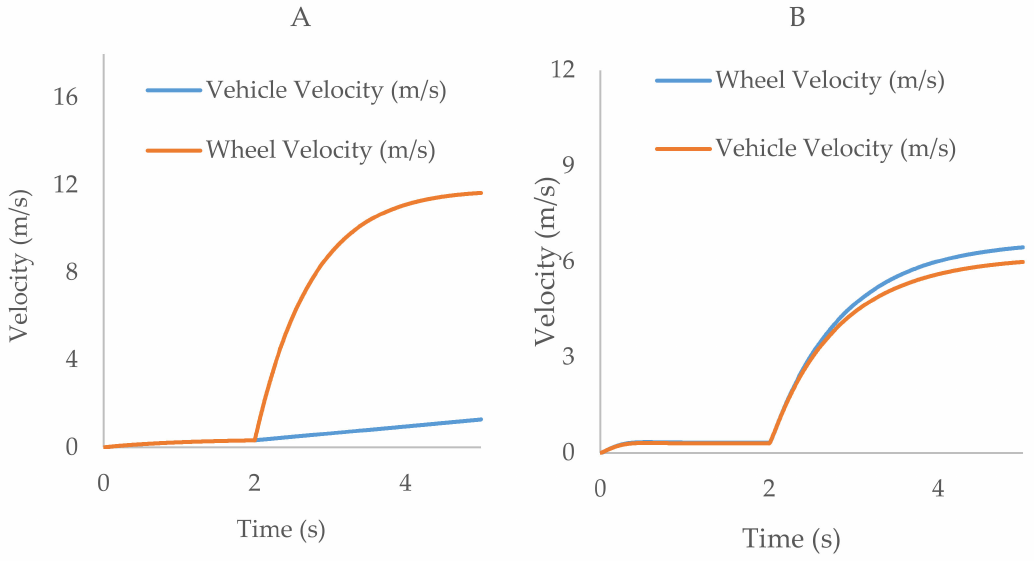
Figure 8. Velocity performance ( A ) without control and ( B ) with control.